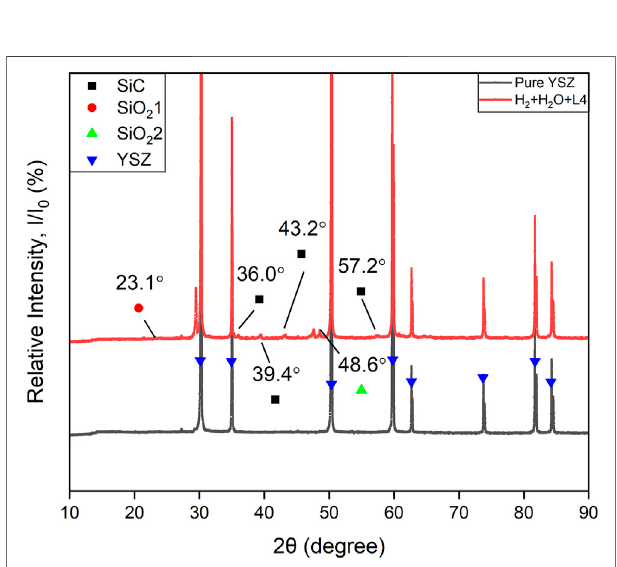
FIGURE 7 | XRD patterns of the YSZ pellet bottom surface (fuel inlet side). Black color line: Pure YSZ sample. Red line: after 96 h H 2 +N 2 +H 2 O+D4 experiment at 750 ° C.